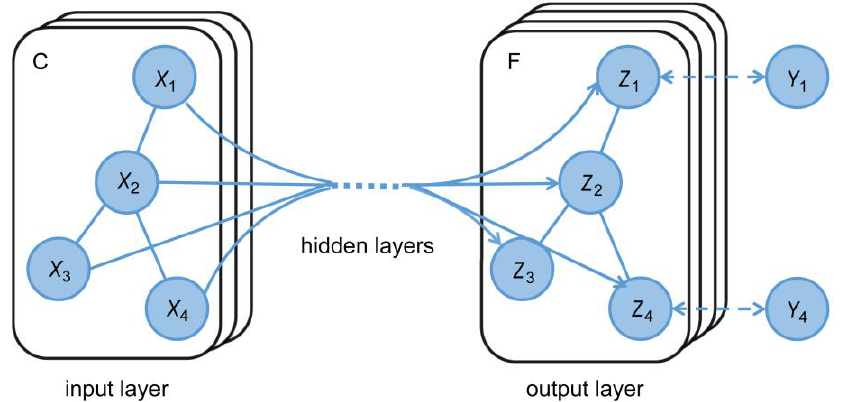
Figure 7. Graph convolutional network structure [107].